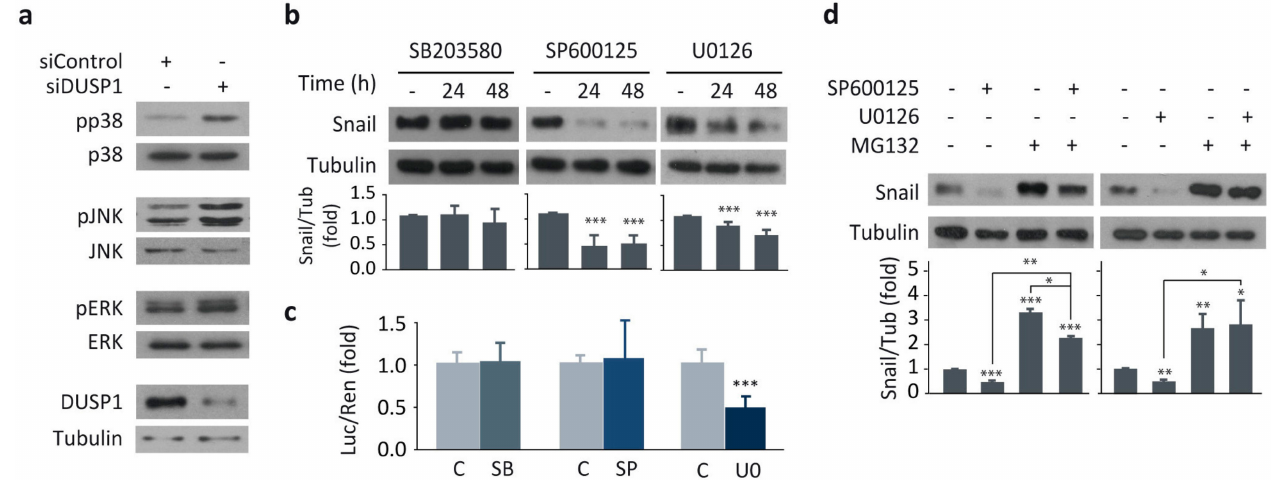
Figure 2. The inhibition of JNK and ERK downregulates Snail expression in DU145 cells. ( a ) Cells were transfected for 48 h with the siControl or the siDUSP1 and expression levels of DUSP1, phosphorylated MAPKs (pp38, pJNK, pERK), total MAPKs and Tubulin were determined by western blotting. ( b ) Cells were incubated at different times in the absence or presence of 1 µ M SB203580 (SB), 10 µ M SP600125 (SP) or 20 µ M U0126 (U0), and expression levels of Snail and Tubulin were determined by western blotting. ( c ) Cells were transfected with the Snail-Luc plasmid, incubated for 48 h as in b and luciferase activity was assayed in cell extracts. ( d ) Cells were incubated for 48 h with 10 µ M SP600125 or 20 µ M U0126, treated in the absence or presence of 10 µ M MG132 for the last 4 h and expression levels of Snail and Tubulin were determined by western blotting. For all the results, data are shown as the mean ± SEM of at least three independent experiments. Student’s t test: * 0.01 < p < 0.05; ** 0.001 < p < 0.01; *** p <